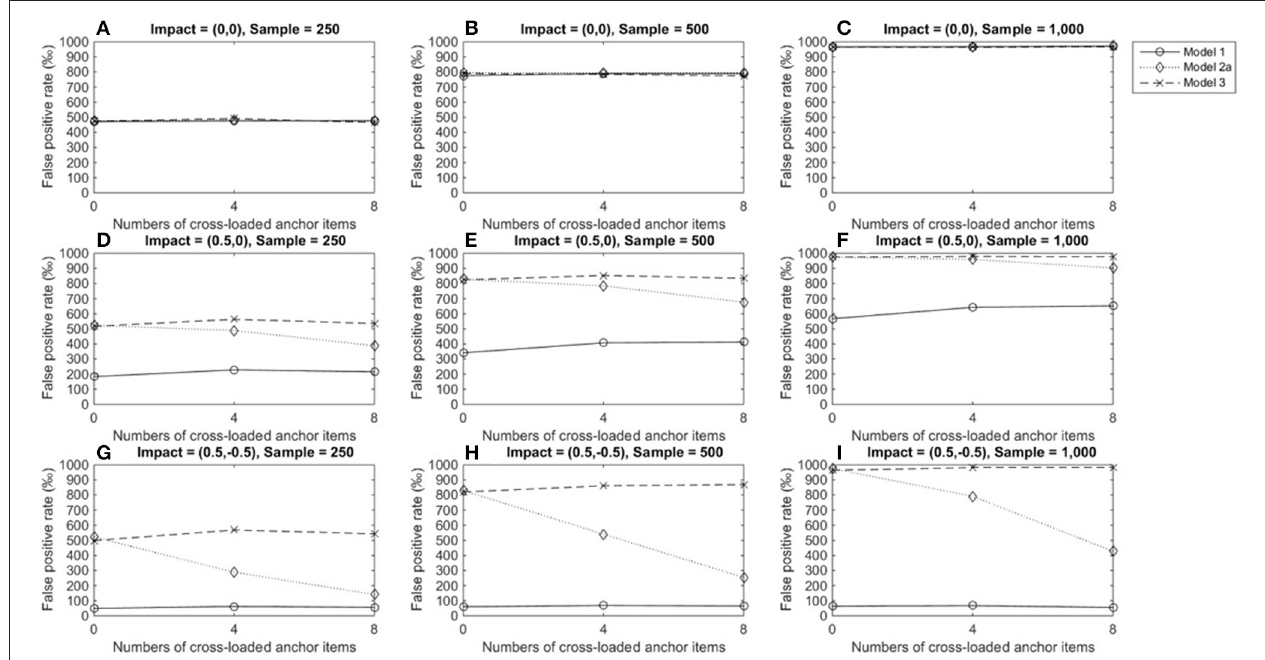
FIGURE 4 | True positive rates when the tested item measured one single domain and DIF magnitude was 0.5. Fore model 1, total score served as a matching variable; for model 2a, the subset score of domain 1 was used to match participants; model 3 used two subset scores as a matching variable. Model 2b was excluded because the tested item did not measure the second domain. (A) Impact = (0,0), Sample = 250; (B) Impact = (0,0), Sample = 500; (C) Impact = (0,0), Sample = 1,000; (D) Impact = (0.5,0), Sample = 250; (E) Impact = (0.5,0), Sample = 500; (F) Impact = (0.5,0), Sample = 1,000; (G) Impact = (0.5, − 0.5), Sample = 250; (H) Impact = (0.5, − 0.5), Sample = 500; (I) Impact = (0.5, − 0.5), Sample =